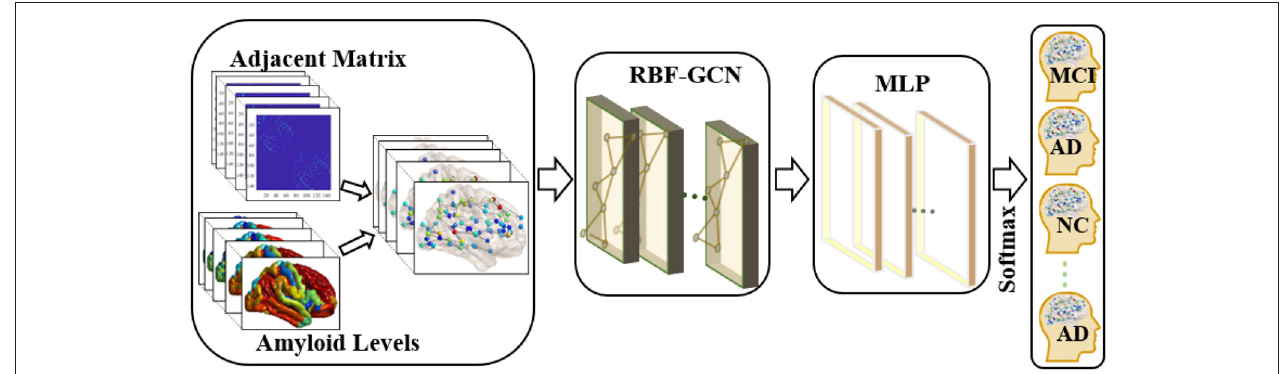
FIGURE 1 | Overview of the pipeline used in the classification of each subject’s clinical diagnosis. First, we applied the graph-structured data to incorporate the topology of the brain network and nodal attributes (i.e., amyloid levels) in each brain region. Then, a regional brain fusion-graph convolutional network (RBF-GCN) model is developed to extract the underlying features of the graph-structured data. Finally, a multilayer perceptron (MLP) module and a Softmax layer are added to predict each subject’s Alzheimer’s disease (AD) stage.